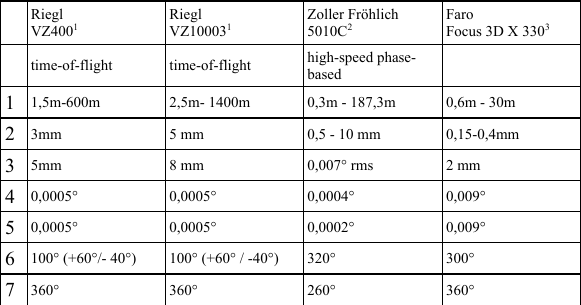
Table 1. Deployed laser scanners: 1 - range; 2 - precision; 3 - accuracy; 4 - vertical resolution; 5 - horizontal resolution; 6 - vertical scan angle range; 7 - Horizontal Scan Angle Range 3.2.2 Cameras: In order to compare the differences in the